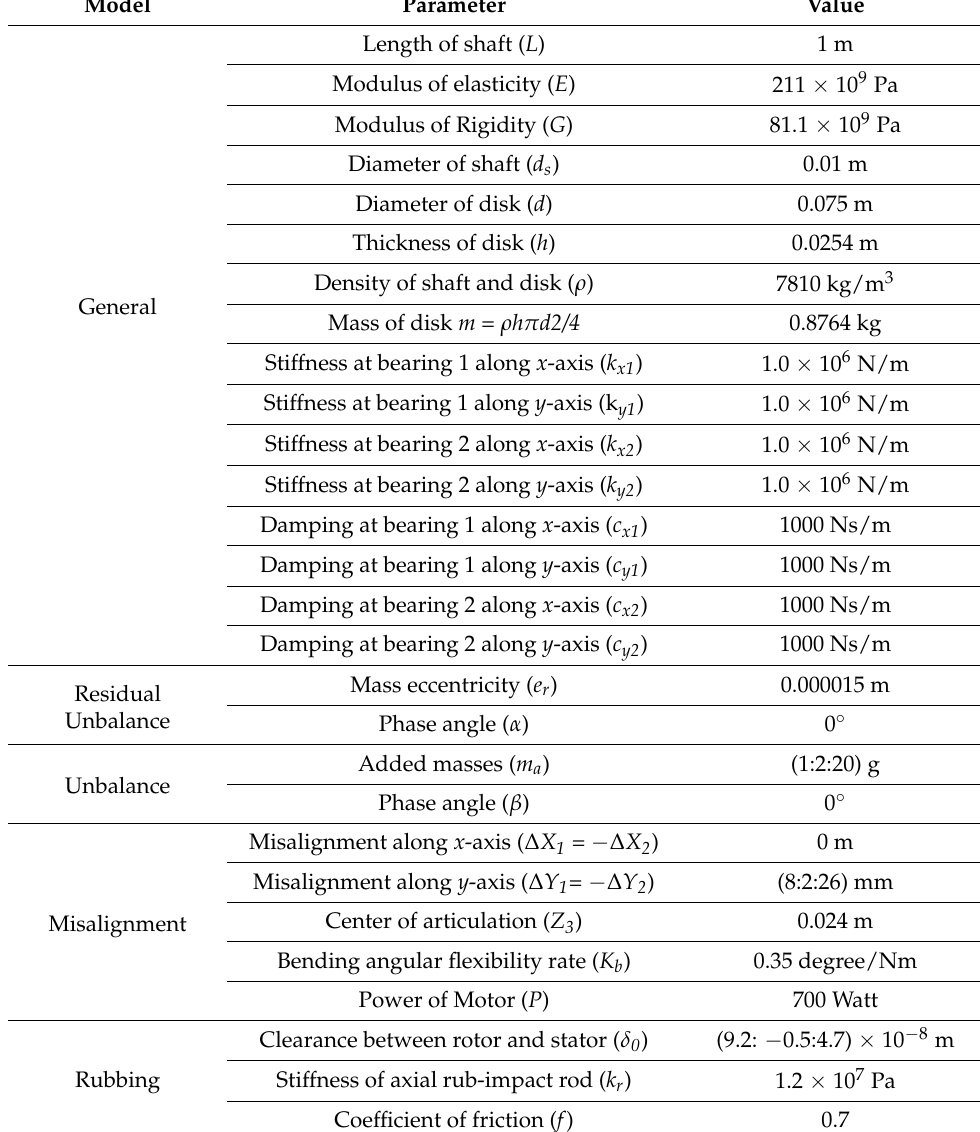
Table 1. Material properties and parameters of the simulation